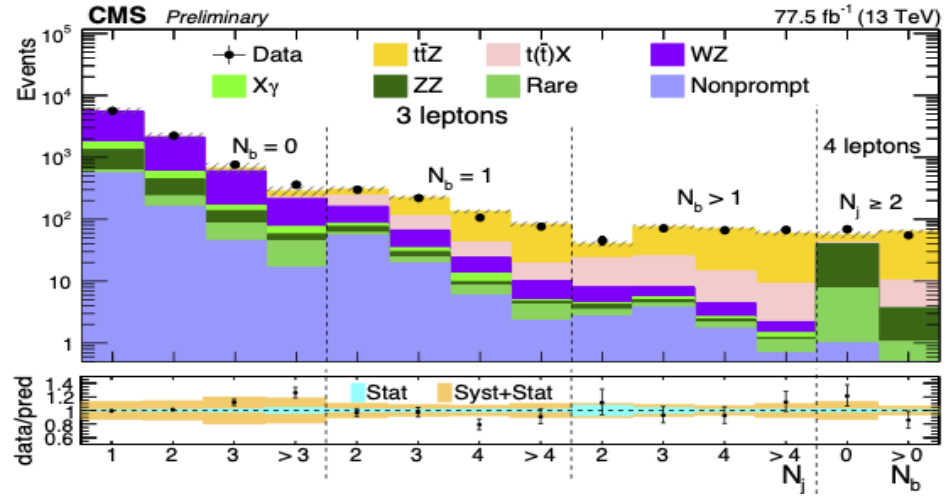
Figure 4. CMS signal regions